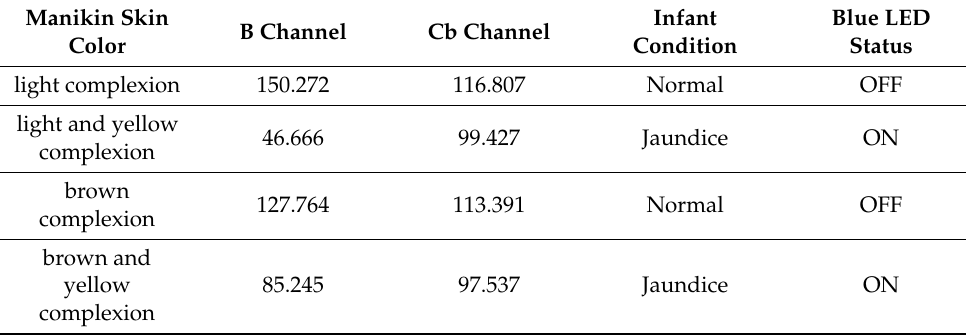
Table 1 summarizes the four different cases considered in Scenario 1. Table 1. The summary of all cases considered in scenario 1.